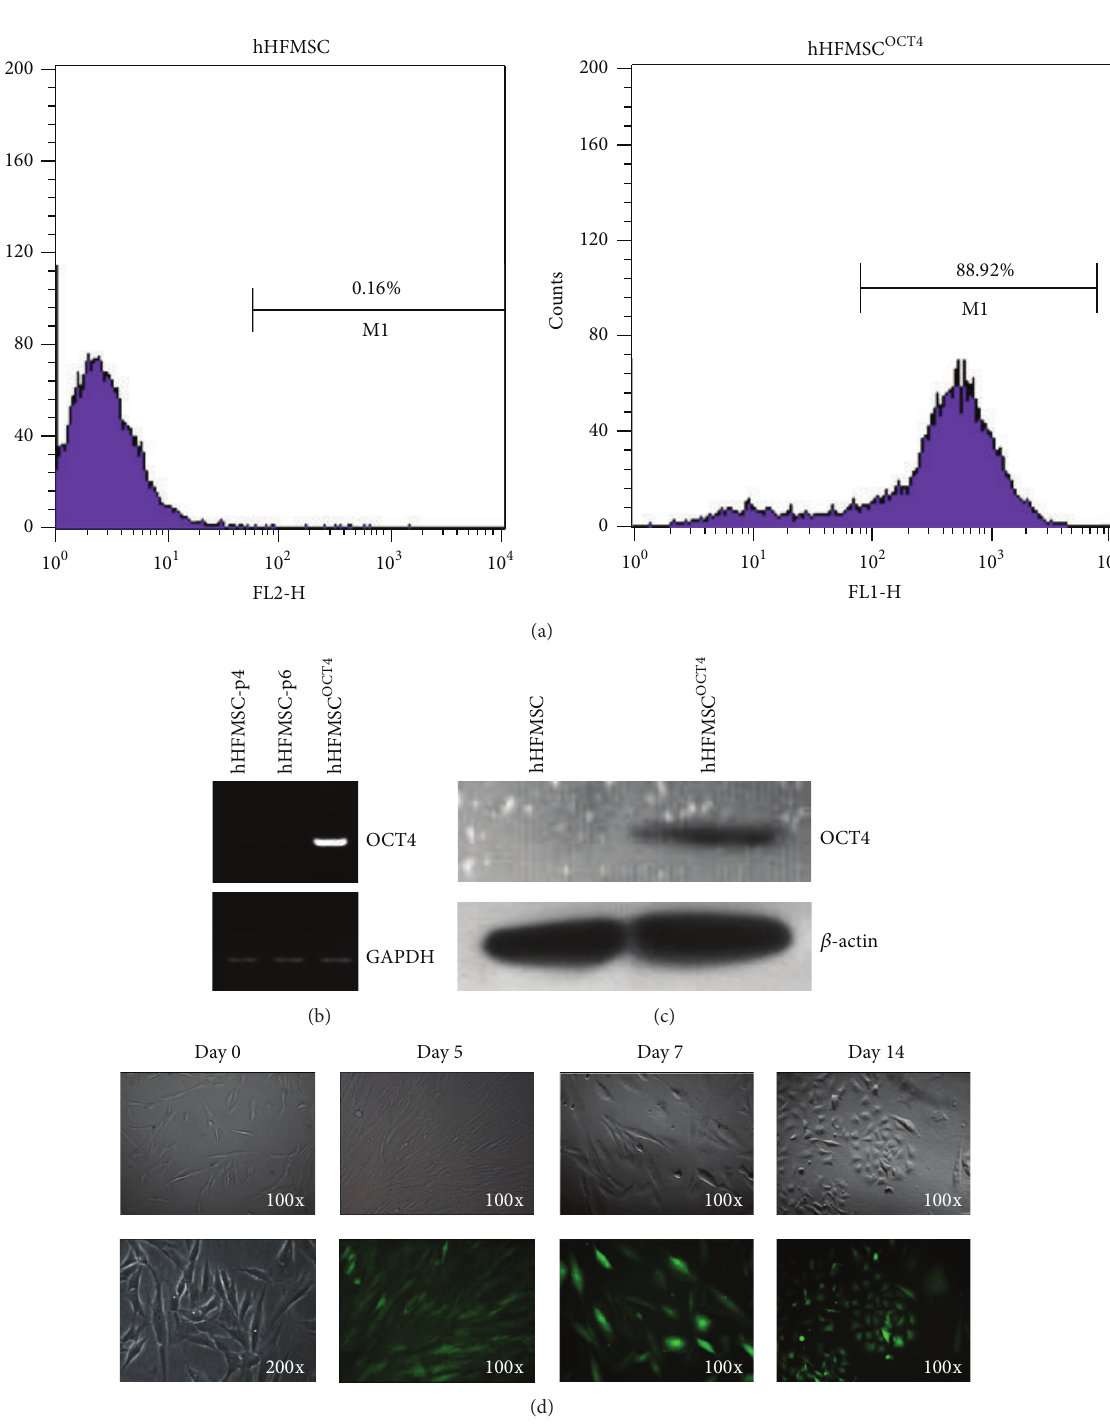
Figure 2: hHFMSCs were transduced with lentivirus encoding OCT4. (a) Flow cytometric plot of GFP expression in hHFMSCs after 12 days of transduction (hHFMSCs OCT 4 ). (b) Semiquantitative RT-PCR results for expression of total RNA OCT4 in hHFMSC OCT 4 . (c) Western blot results for expression of total proteins of OCT4 in hHFMSCs OCT 4 . (d) Cell morphologies were changed between 0 and 14 days after OCT4